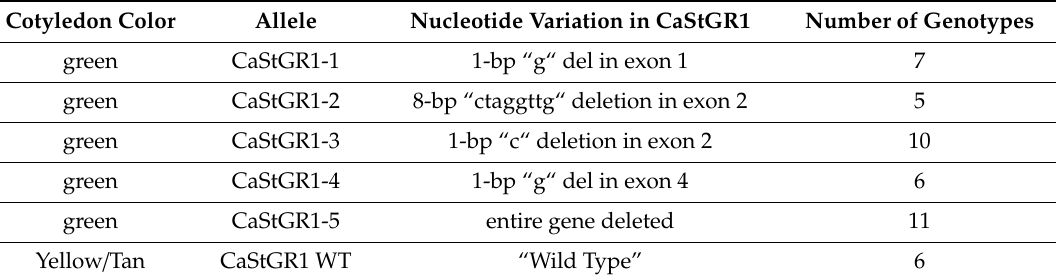
Table 1. Summary of nucleotide variants identified in CaStGR1 among chickpea germplasm. The color of cotyledons, designated allele names for the variants, the nature of molecular lesions found in each allele, and their frequencies among germplasm studied are